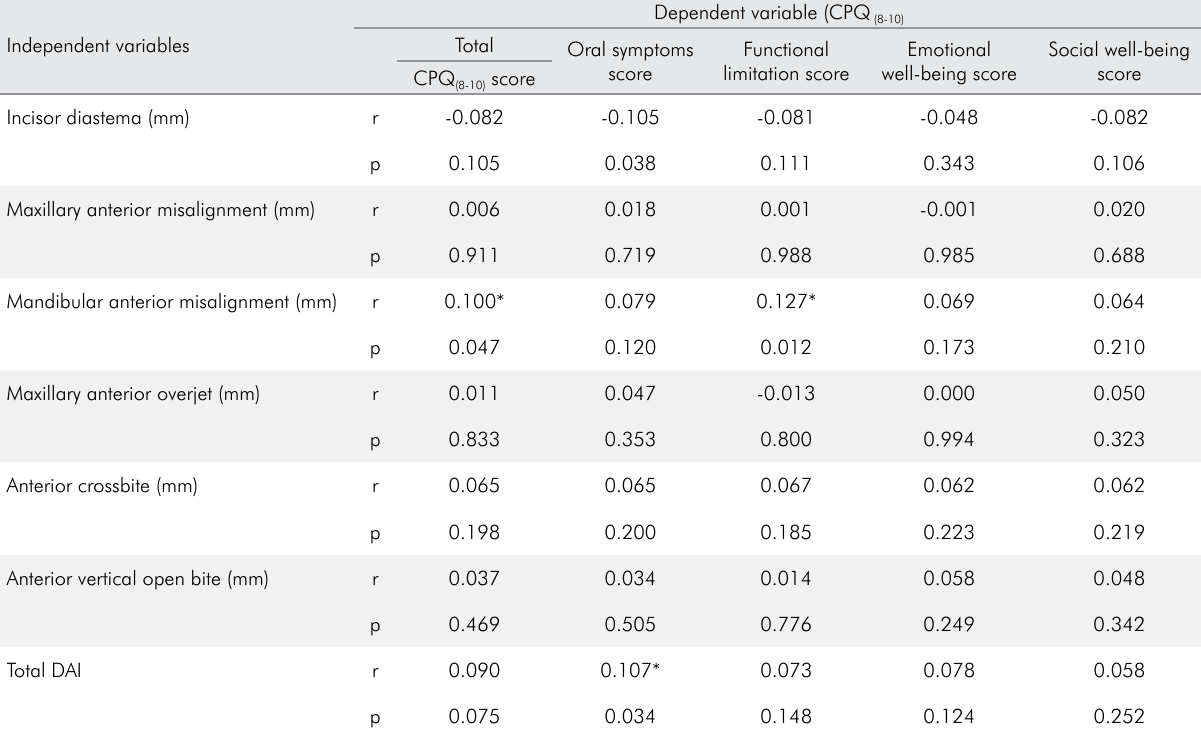
Table 3. Impact on oral health-related quality of life (CPQ (8-10)) according to DAI variables (n = 390); Diamantina, Brazil, 2013. Independent